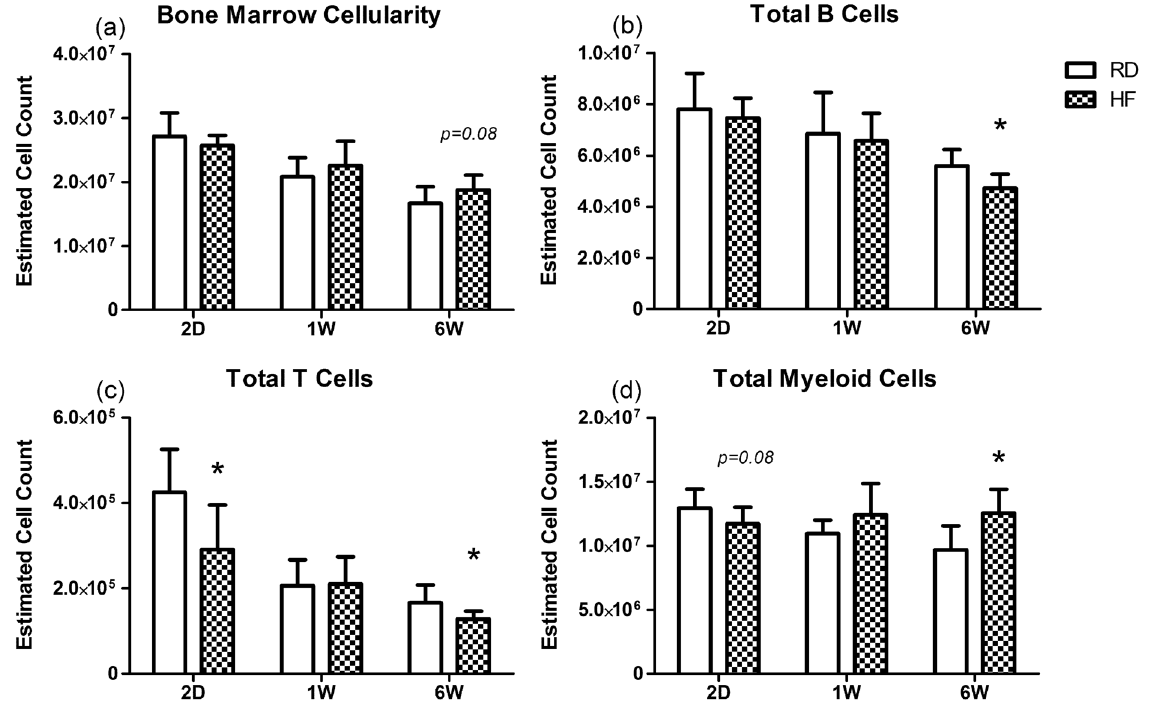
Figure 4. High Fat Diet Alters the Total Population Sizes of BM Leukocytes. (a) Total BM cells harvested for flow cytometry were not different between HF and RD animals at any time point, but a trend of increase was observed at 6W. (b) The total number of B-cells was not changed at 2D or 1W contrary to a decline in the phenotypic population at 1W. However, B-cells were reduced at 6W, despite a slight increase in total cellularity, demonstrating the degree of population reduction. (c,d) Total population sizes of both T-cells and Myeloid lineages tracked well with the phenotypic population proportions. * P , 0.05 vs. RD.